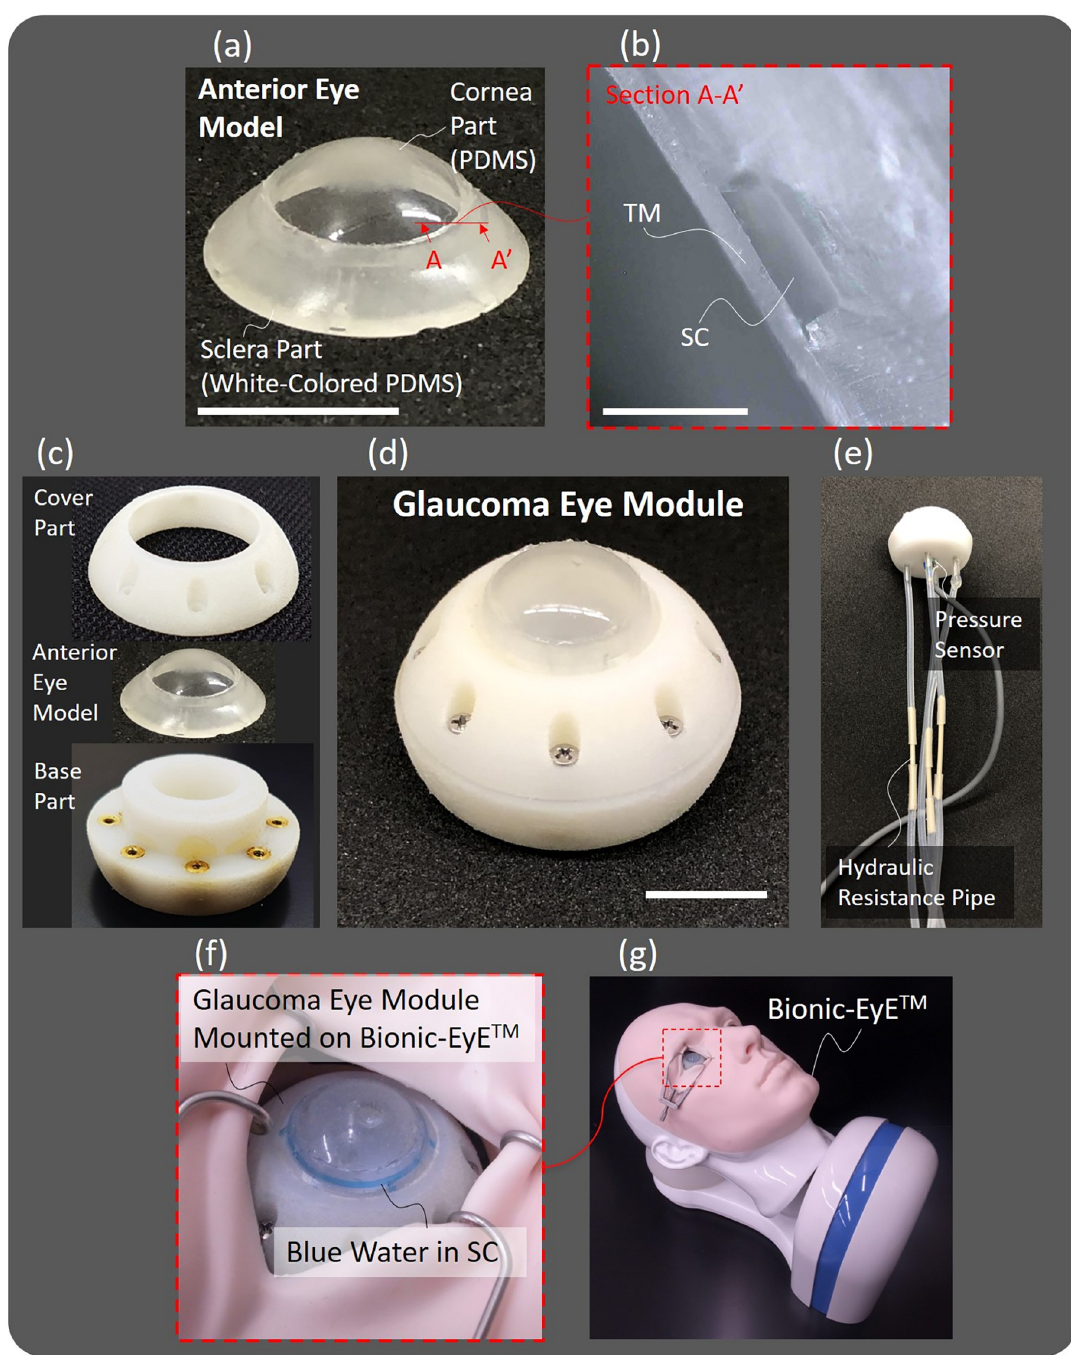
Fig 6. MIGS simulator prototype. (a) Fabricated anterior eye model. (b) A microscopic image of the section around the SC. A bar means 500 μ m. The TM thickness was 90 μ m and the cross-section widths of the SC were 170 and 550 μ m. (c) Configuration of glaucoma eye module. (d) Assembled glaucoma eye module. A bar means 10 mm. (e) Fluid/electrical components on the outside of the glaucoma eye module. (f) The glaucoma eye module in which blue water is injected into the SC. (g) The glaucoma eye module mounted on the Bionic-EyE ™